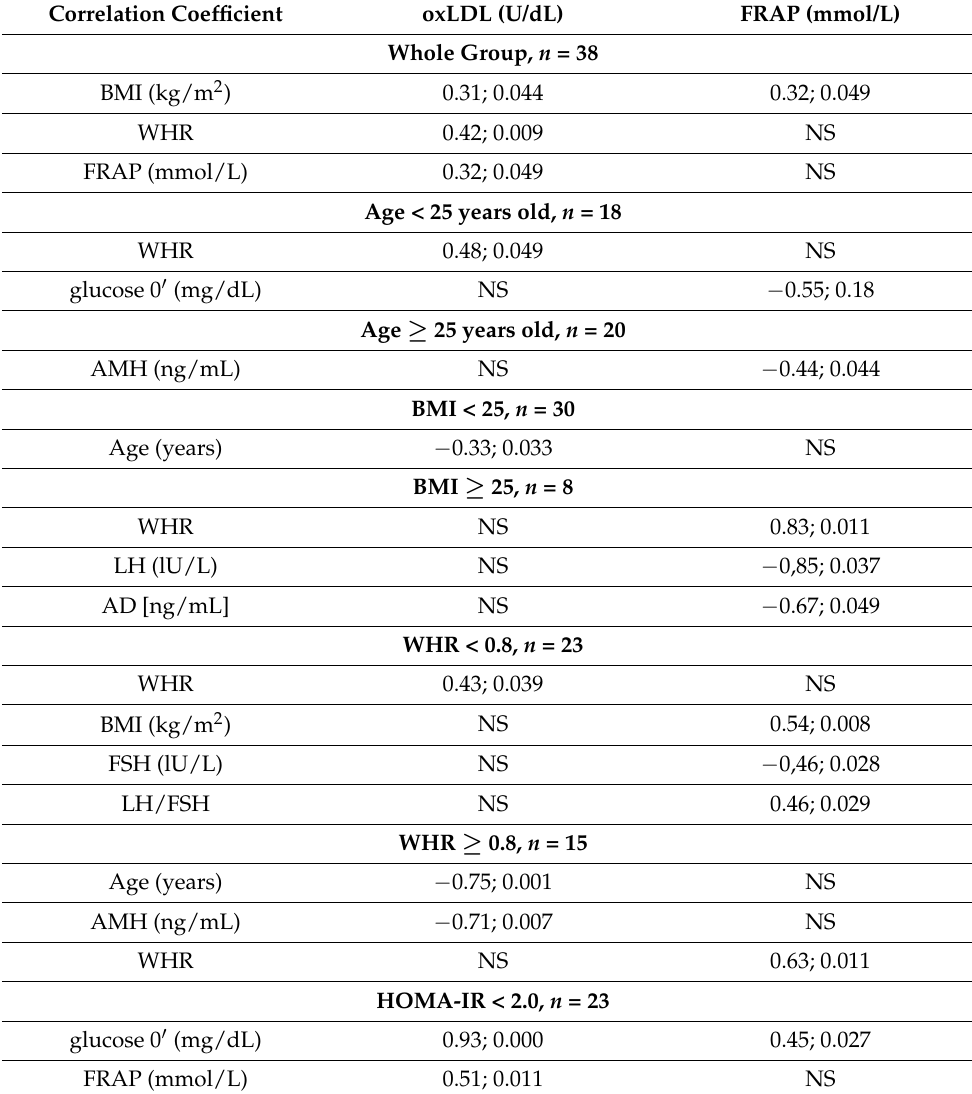
Table 5. Correlation coefficient between the concentration of oxLDL or FRAP and studied parameters in subgroups of PCOS